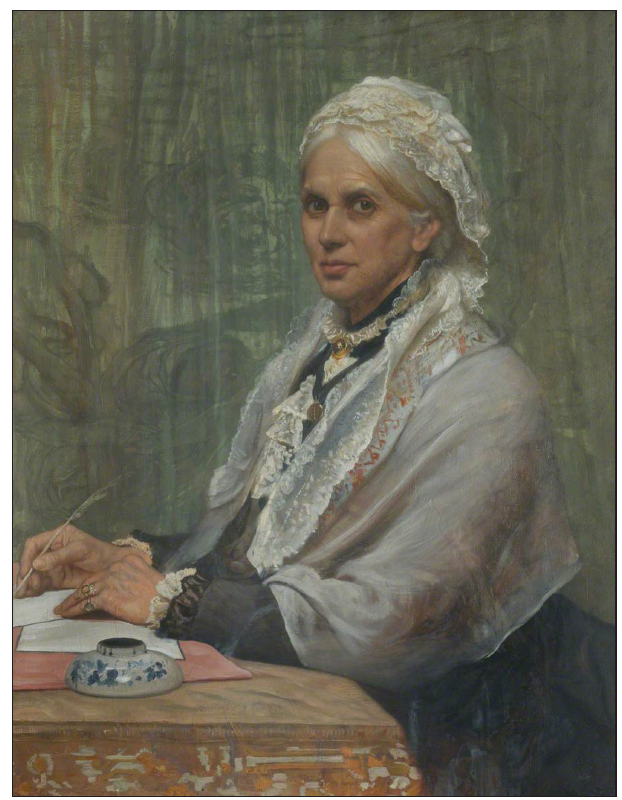
Fig. 2 : William Blake Richmond, Anne Jemima Clough, First Principal , 1882, oil on canvas, 90 × 69.5 cm, Newnham College, University of Cambridge,